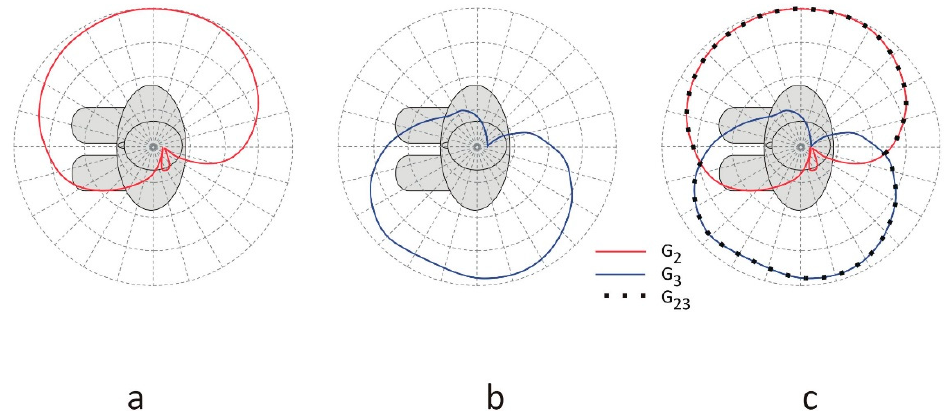
Figure 2. The off-body communication scenario: ( a ) transmission for antenna 2 with gain G 2 ; ( b ) transmission for antenna 3 with gain G 3 ; ( c ) transmission for both antennas 2 and 3 with the resultant gain G 23 . It should be noted that in any given direction, G 23 is not the arithmetic sum of G 2 and G 3 but the greater of the two, because the two transceivers operate at the same frequency but in different time slots. In that sense, this is not a two-element antenna array with the superposition of radiation patterns but a switched pattern antenna.